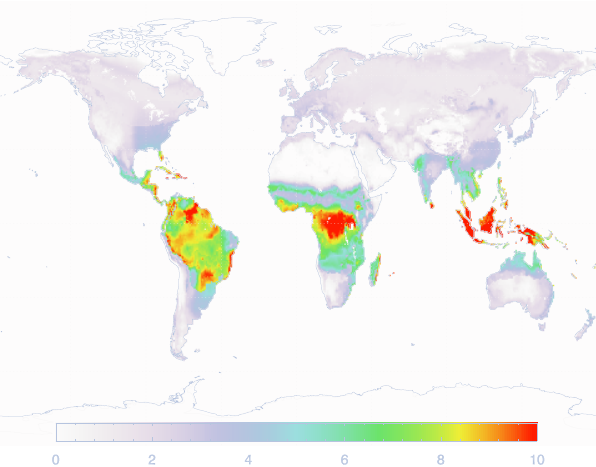
Figure 2. Geographic distribution of the modelled terrestrial ecosystems demand for newly fixed N (NNF, gNm − 2 yr − 1 )